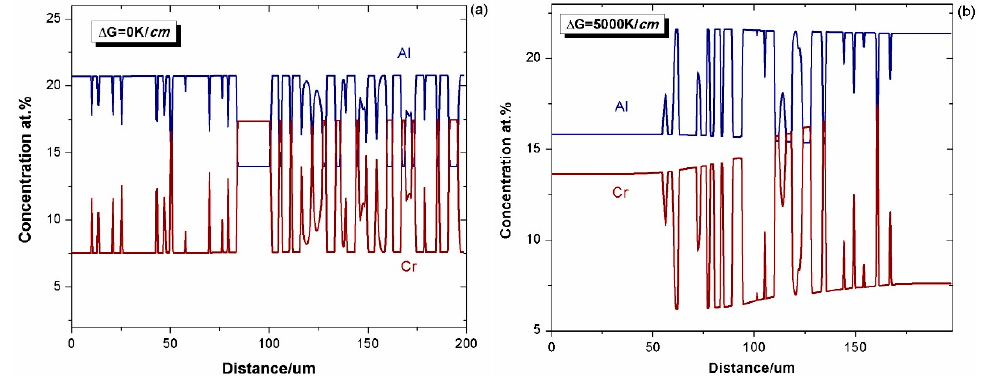
Figure 8. Composition distribution of Al and Cr in No. 3 γ + γ '/ γ + γ ' bond coat/substrate system (Ni–20at.%Al–8at.%Cr/Ni–18at.%Al–12at.%Cr) annealed ( a ) at 1373 K and ( b ) with an effect of temperature gradient Δ G = 5000 K/cm at 510,000 s.